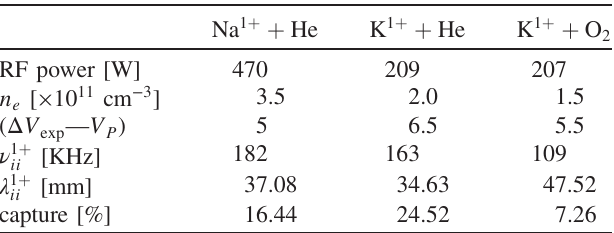
TABLE VIII. Estimated ion-ion collision frequencies (lower limit) and the 1 þ mean free path (upper limit) for Na 1 þ and K 1 þ ions, and the corresponding He and O 2 plasma densities at different microwave powers. The value of Coulomb algorithm is assumed as 10.